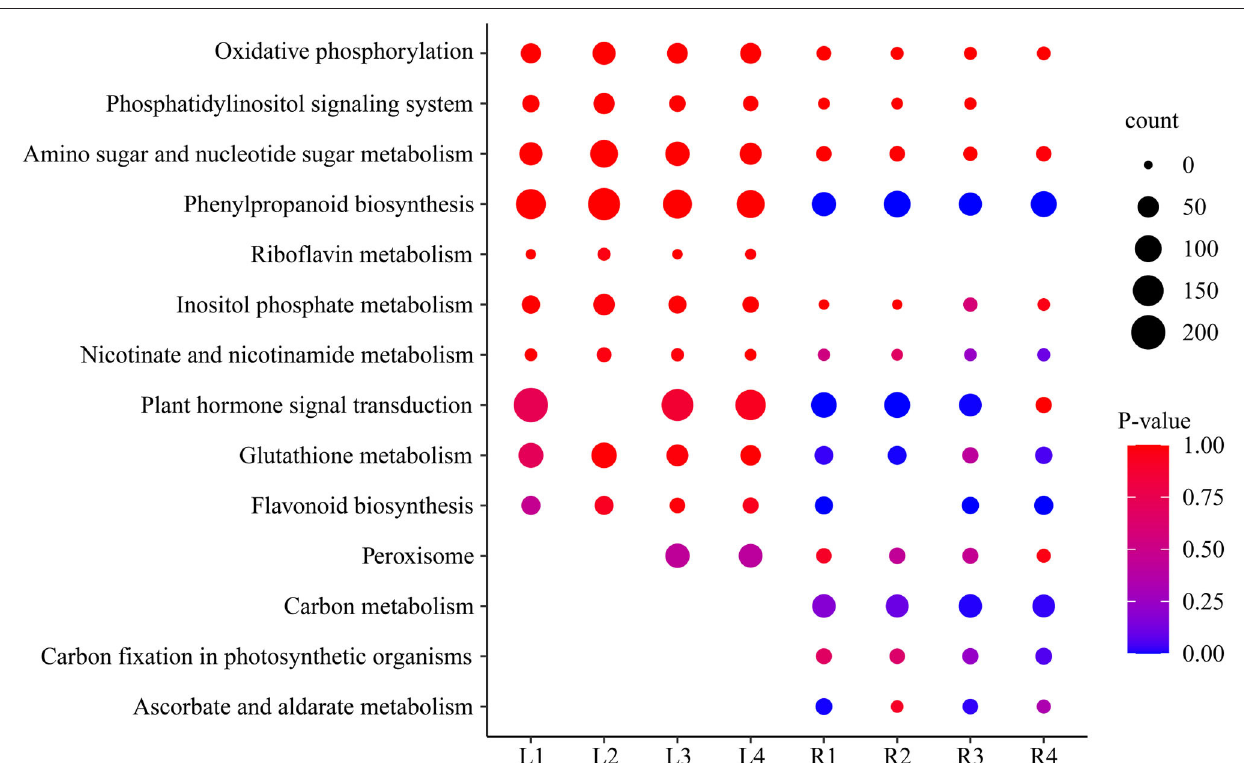
FIGURE 5 | Scatter plot of the enriched KEGG pathway of DEGs under NaCl stress.